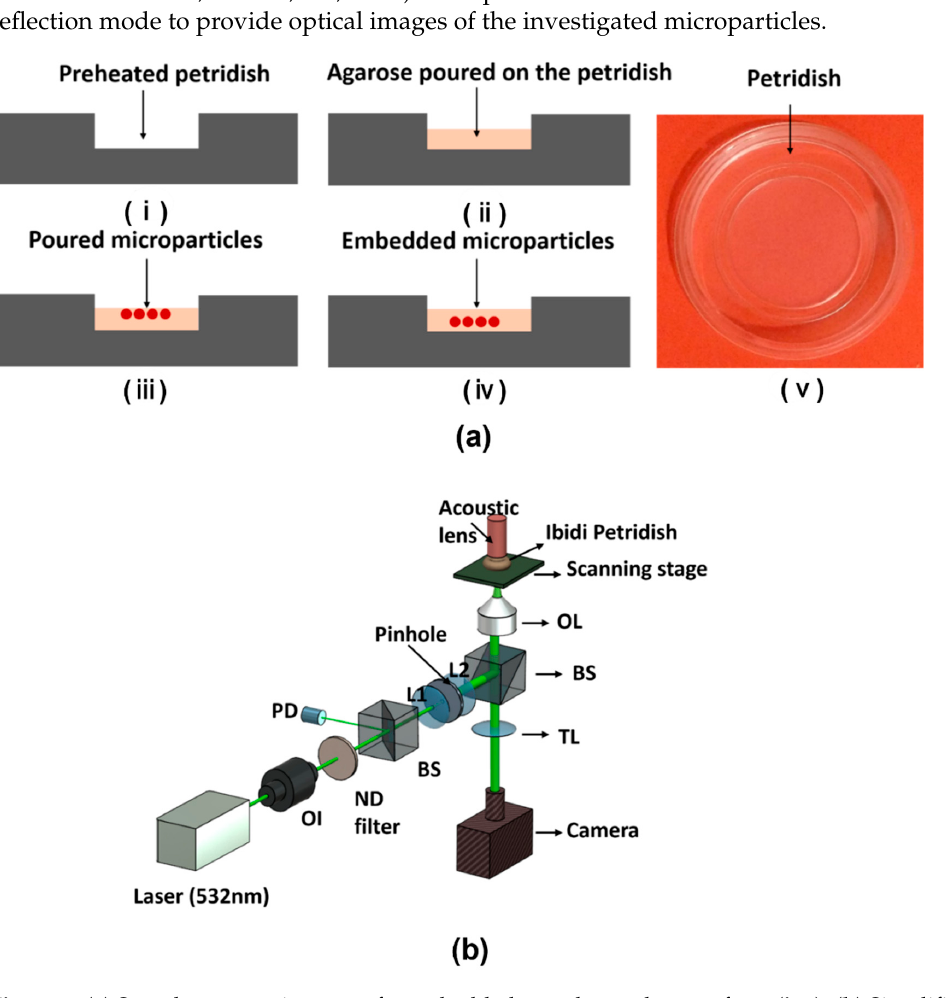
Figure 1. ( a ) Sample preparation steps for embedded sample step by step from ( i – v ). ( b ) Simplified PAM (Photoacoustic microscopy) experimental setup. OI: Optical isolator, BS: Beam splitter, ND filter: Neutral density filter, PD: Photodiode, OL: Objective lens. TL: Tube lens.